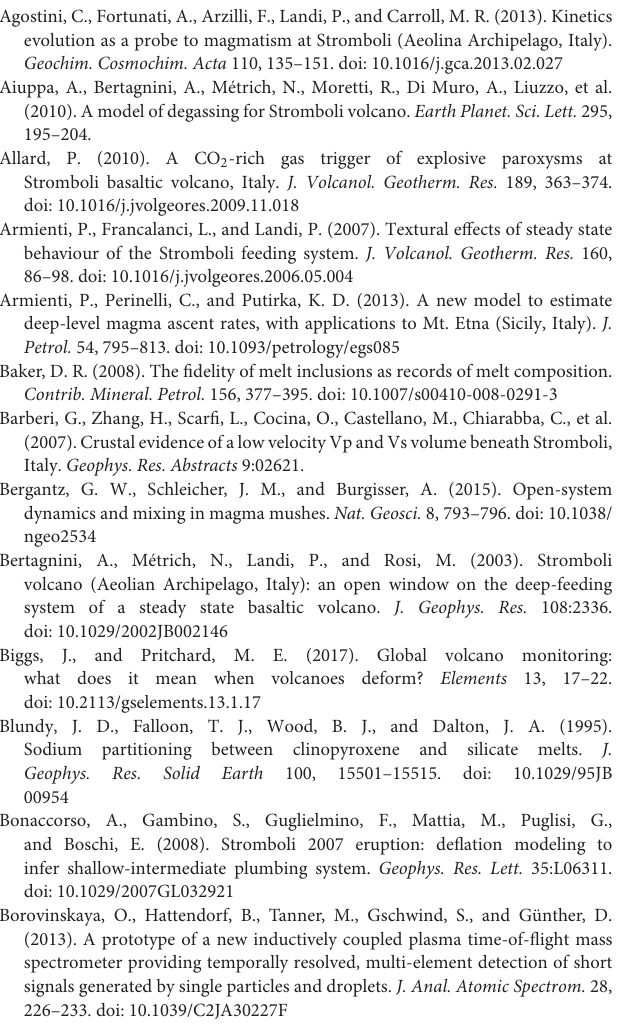
fractionation (cooling) step, melt data are listed first, followed by data on fractionated clinopyroxene (where present). Supplementary File 1 | Ubide et al. (2019) Frontiers in Earth Science